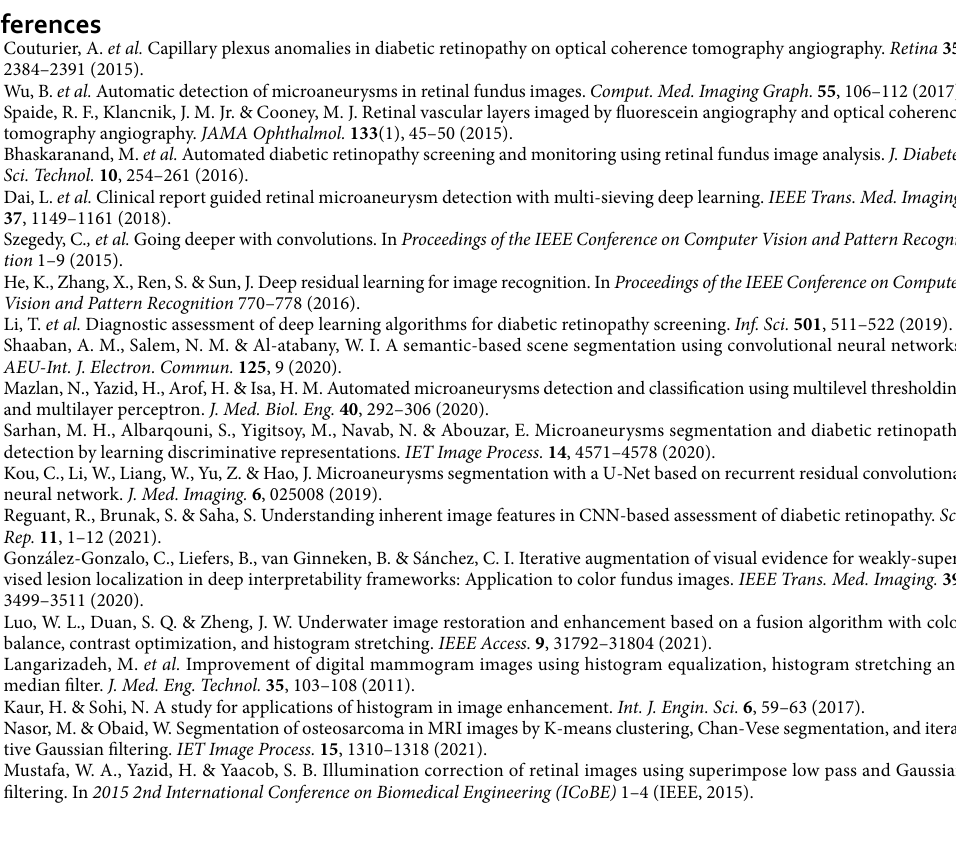
Table 3. Comparison of MA detection performance by DeeplabV3+, PSPNet, and MAs-FC-DenseNet.